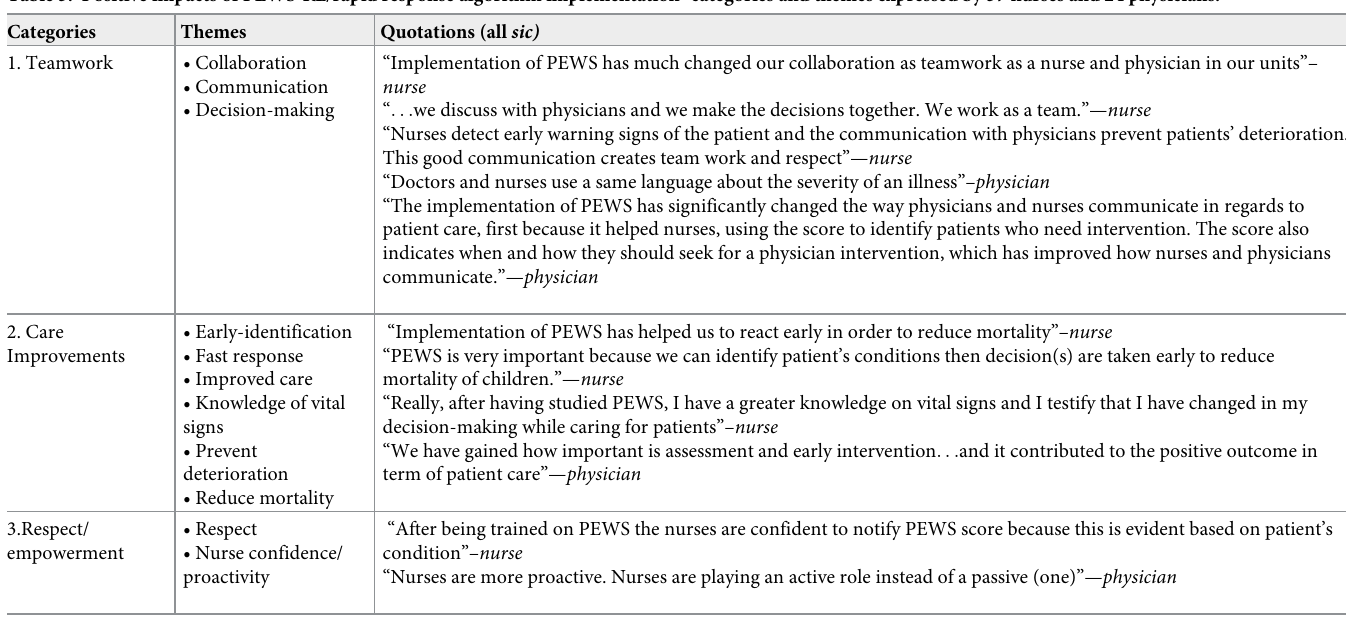
Table 3. Positive impacts of PEWS-RL/rapid response algorithm implementation -categories and themes expressed by 37 nurses and 24